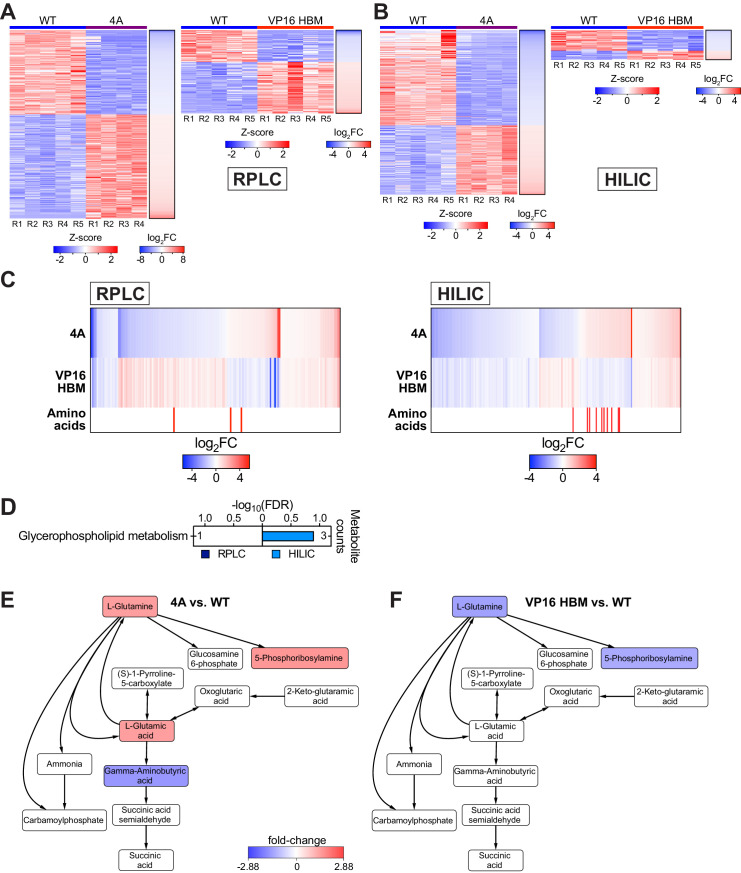
Impact of the 4A and VP16 HCF-1-binding motif (HBM) mutants on Ramos cell metabolites.All data are derived from switchable Ramos cells treated with 20 nM 4-OHT for 24 hr. (A and B) Heatmap visualizing consistency between replicates of metabolites (z-transformed) detected with reverse-phase liquid chromatography (RPLC) (A) or hydrophilic interaction liquid chromatography (HILIC) (B) that were significantly (false discovery rate [FDR] < 0.05 and |FC| > 1.5) impacted by the 4A (left) or VP16 HBM (right) MYC mutants. Shown alongside each is a heatmap is the log2FC as calculated from the raw data. (C) Heatmap showing metabolites detected with RPLC (left) or HILIC (right) that are significantly (FDR < 0.05) changed for both the 4A and VP16 HBM mutants, compared to wild-type (WT) MYC. Metabolites are clustered according to the relationship between the two mutants, and ranked by the log2FC of 4A versus WT. The position of amino acids is highlighted in red. (D) Annotated metabolites from (C) that were changed in the same direction for the 4A and VP16 HBM mutants were independently subjected to pathway enrichment analysis. Pathways with FDR < 0.2 for either RPLC and HILIC are shown. (E) Metabolites in the ‘alanine, aspartate, and glutamate metabolism’ pathway that are significantly (FDR < 0.05) impacted in the 4A mutant. Node color represents the fold-change (FC) over WT. The remainder of the pathway is shown in Figure 2H. (F) Metabolites in the ‘alanine, aspartate, and glutamate metabolism’ pathway that are significantly (FDR < 0.05) impacted in the VP16 HBM mutant. Node color represents the FC over WT. The remainder of the pathway is shown in Figure 2H.